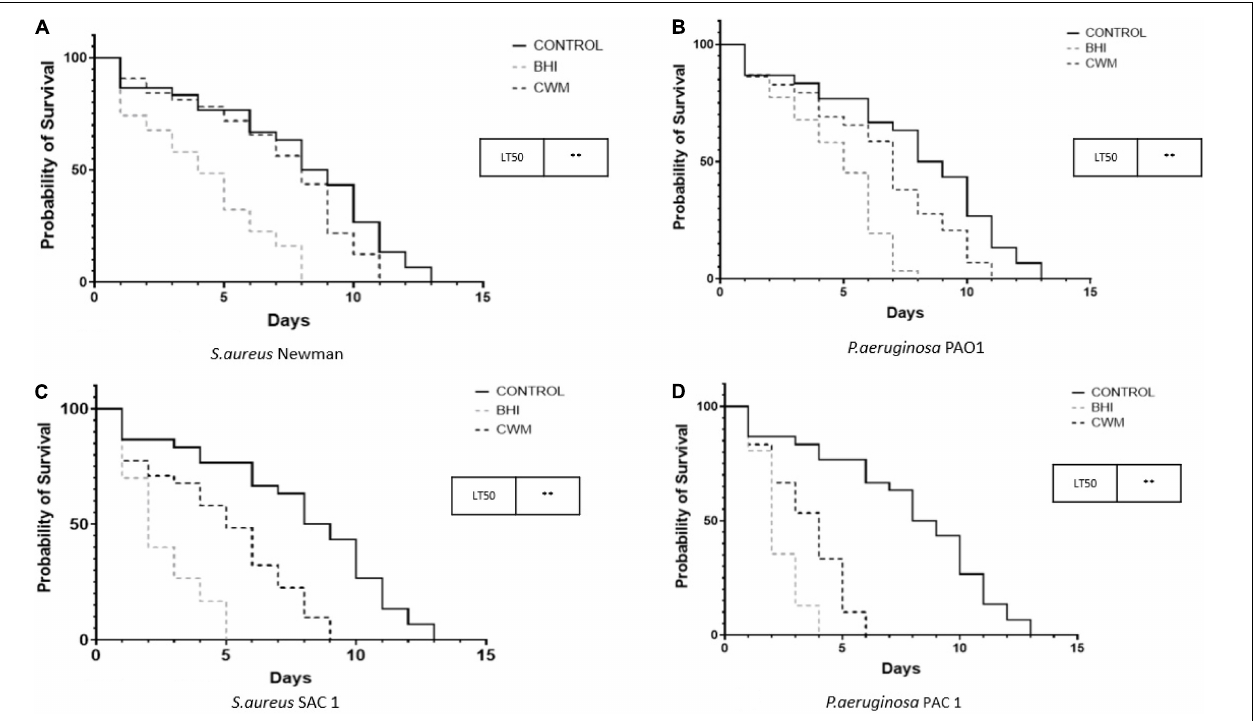
FIGURE 5 | Nematode killing assays of monoinfections with reference (A,B) and clinical (C,D) strains of S. aureus and P. aeruginosa cultured in the different growing